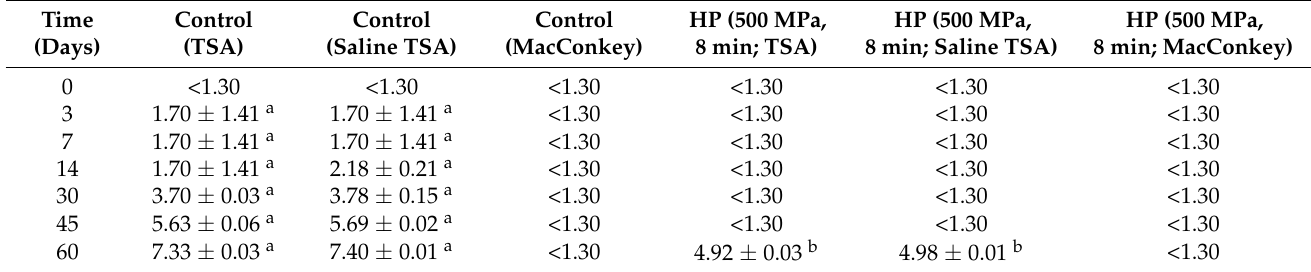
Table 1. Results for trial 1. Viable cell counts (log CFU/g) obtained on non-selective and on selective media for the controls (cod heated at 57.1 ◦ C for 30 min) and the samples processed by